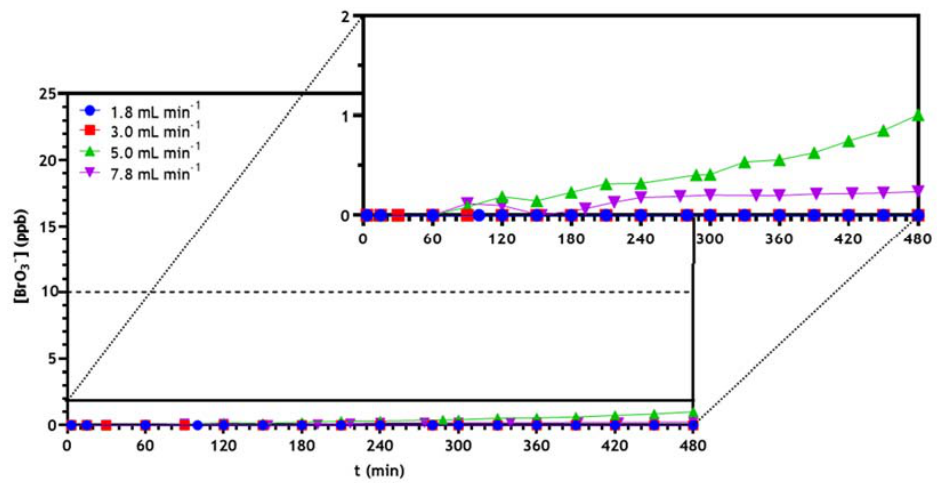
Figure 5. Bromate concentration (ppb) during continuous hydrogen reduction over the catalyst 1 wt.% Pd/MWCNT ‐ O mixed with 0.500 mm carborundum under H 2 using different feed flow rates of water containing bromate. (200 mg CAT , H 2 = 50 cm 3 min − 1 , C (BrO 3 ‐ ) = 200 ppb).